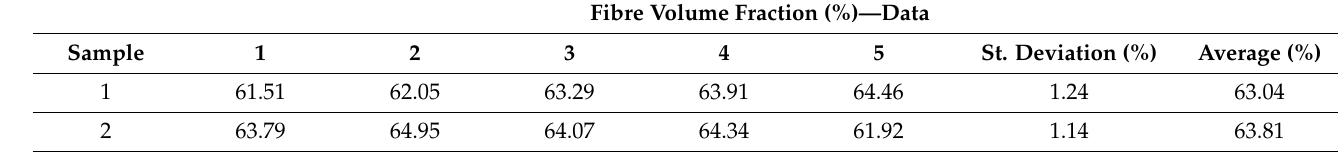
Table A5. Compression test FVF results of the second two specimens, compressed at 200 ◦ C and 10 min of dwell time, with various compaction pressures (sample 1 with 10 MPa, 2 with 8 MPa, 3 with 6 MPa, 4 with 4 MPA, 5 with 2